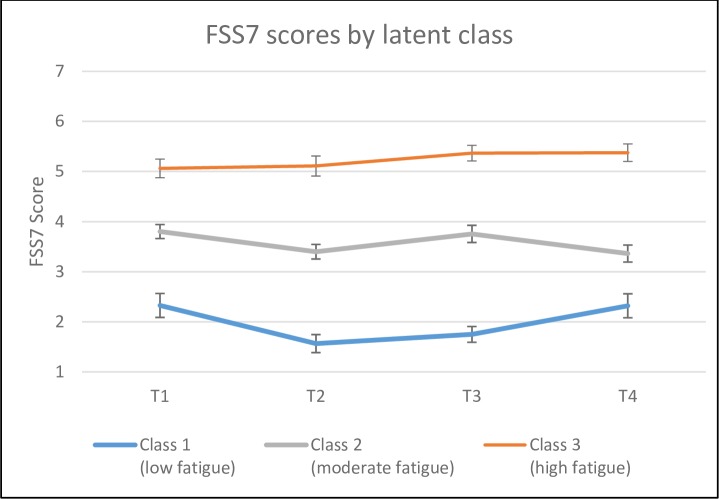
FSS7 scores by latent class.